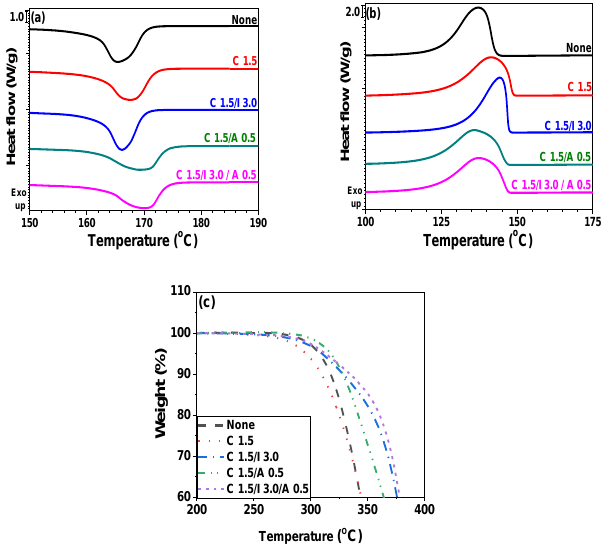
Figure 10. Thermal properties of pristine POM, POM/CNT (POM/C1.5), POM/CNT/ionomer (POM/C1.5/I3), POM/CNT/cyanuric acid (POM/C1.5/A0.5), and POM/CNT/ionomer/cyanuric acid (POM/C1.5/I3/A0.5) composites: ( a ) DSC heating and ( b ) cooling traces; ( c ) TGA thermograms.